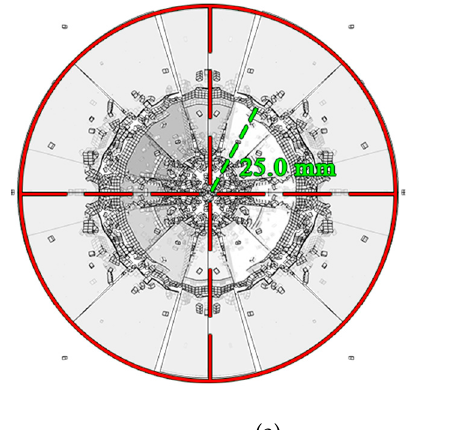
Figure 8. Comparison of the size of fragments. ( a ) Numerical result; ( b ) experimental result [46].